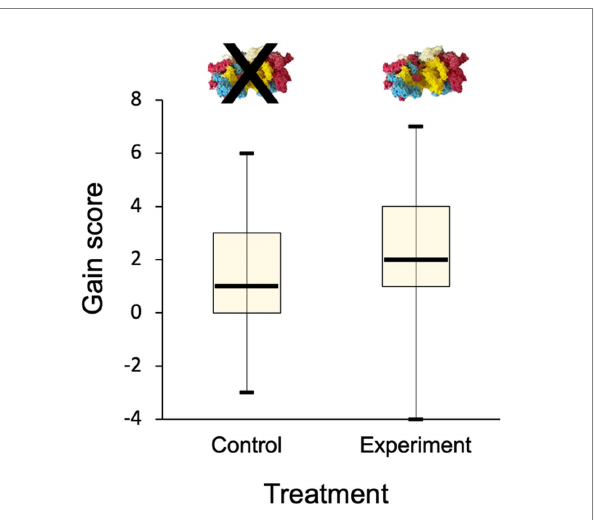
FIGURE 5 Comparison of gain scores obtained from the students who participated in the study ( n = total number of students = 85). The gain scores were calculated as the differences between the pretest and posttest scores obtained by students within each group. The “Control” group consisted of students that were submitted to the theoretical explanation, and the “Experimental” group consisted of students that were submitted to the presentation of the 3D printed molecules. Horizontal lines indicate median values and boxes indicate 1st and 3rd quartiles. We used the non-parametric Mann– Whitney test for comparison because data distribution was not normal (see text for